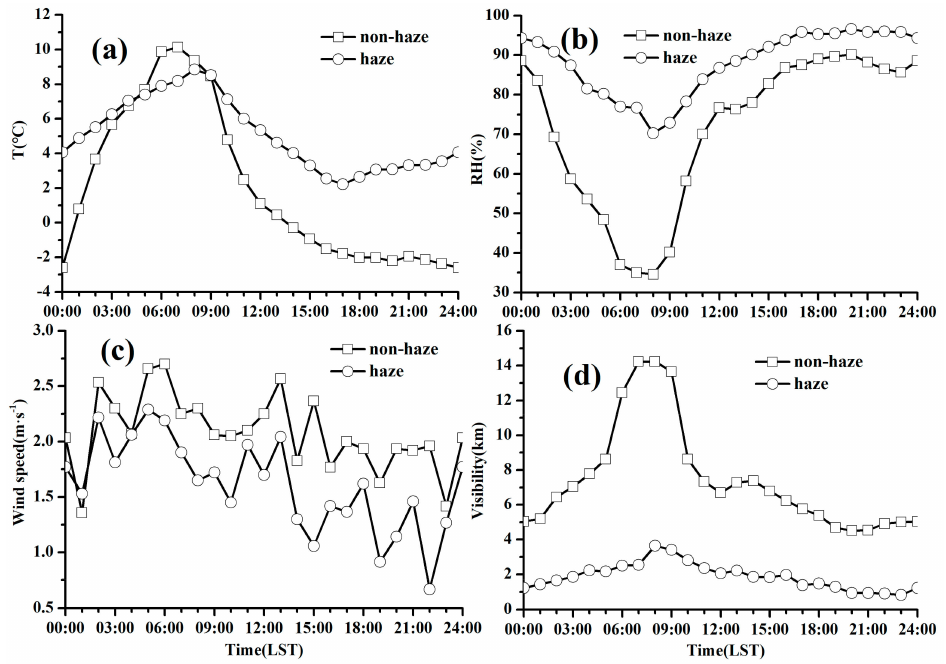
Figure 5. Diurnal variation of T ( a ), RH ( b ), wind speed ( c ) and visibility( d